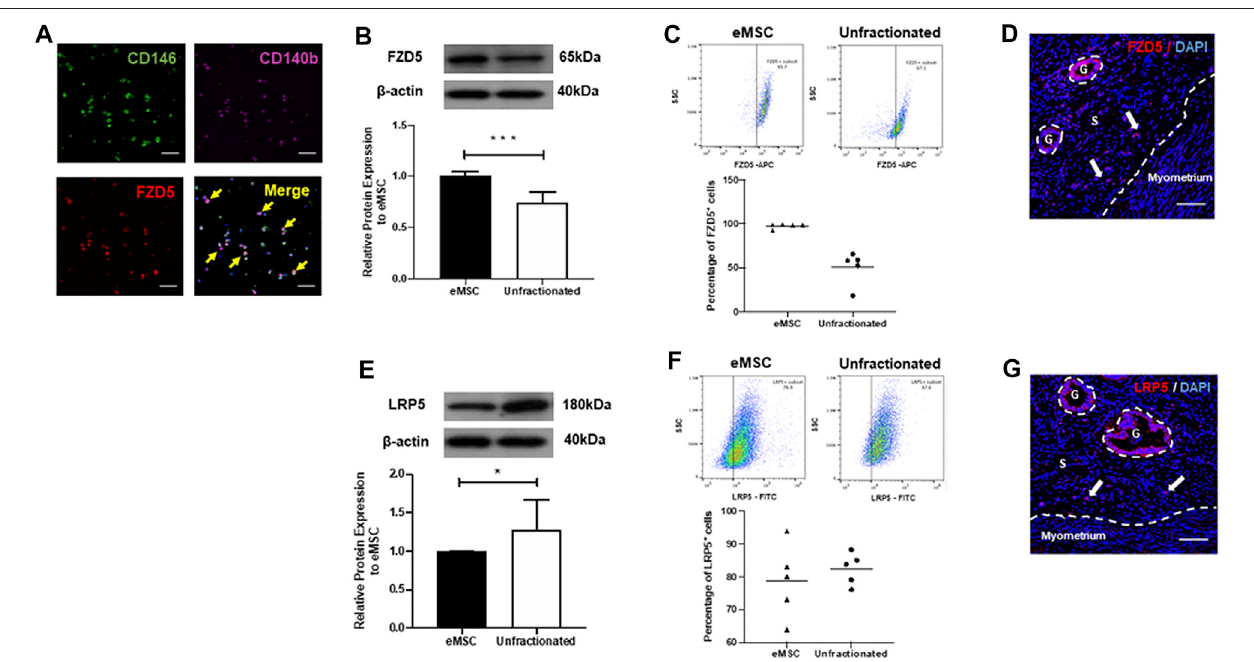
FIGURE 2 | Expression of FZD5 and LRP5 in subpopulations of stromal cells and in human endometrial tissue. (A) The expression of CD146 (green), CD140b (pink), and FZD5 (red) in eMSC was con fi rmed by immuno fl uorescent staining ( yellow arrows ). Representative western blotting images and quantitative analysis of (B) FZD5 (n=7) and (E) LRP5(n =6) protein expression in eMSC (black bars) and unfractionated stromalcells (white bars) normalized to β -actin. Percentage of (C) FZD5 or (F) LRP5 expressing cells using fl ow cytometry in eMSC (CD140b + CD146 + cells, triangles) and unfractionated stromal cells (dots, n = 5). (D) Human endometrial tissue stained with FZD5 (red). Stromal cells residing near the endometrial – myometrial junction express FZD5 ( white arrow ). (G) Human endometrial stained with LRP5 (red). Stromal cells residing near the endometrial – myometrial junction express LRP5 ( white arrow ). Results are presented as mean ± SD; * p < 0.05, *** p < 0.001.